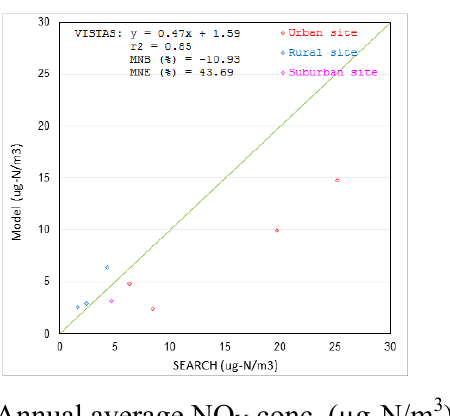
concentrations and ( b ) Hourly Y